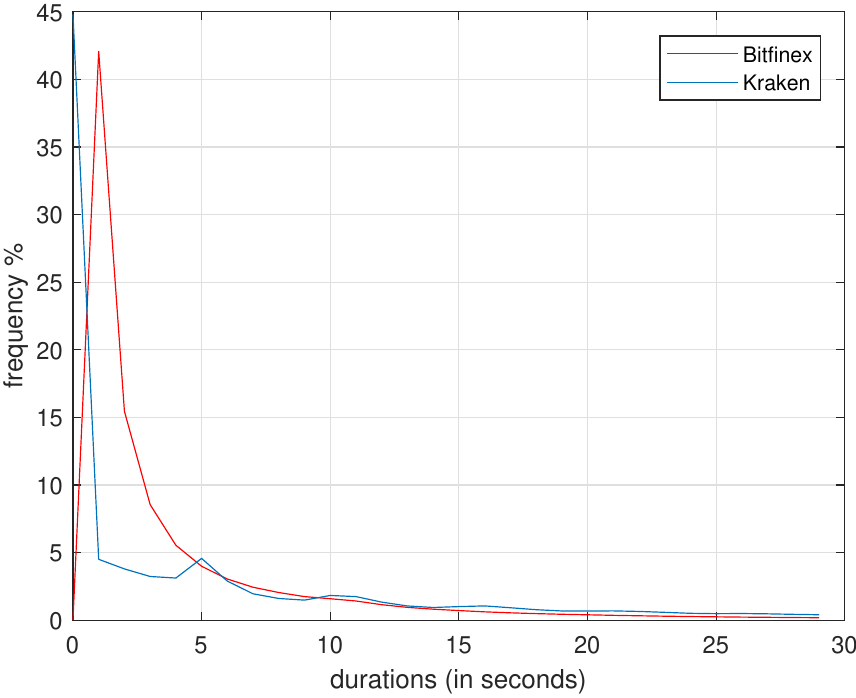
Figure 3. Distribution of price durations. Note. The figure presents the distribution of price durations of Bitfinex (red line) and Kraken (blue line). The duration length is capped at 30 s. Figure 4 sheds light on the intraday development of price durations. We split the day in 30 min intervals and calculate the average across the whole sample for the respective interval. As can be seen, there is a pronounced time-of-day effect on both exchanges: Price durations are substantially lower in the period from 8:00 a.m. UTC (Bitfinex) or 10:00 a.m. UTC (Kraken) till 12:00 a.m. UTC. These times correspond roughly to the trading times of European and U.S. stock markets. As we have Bitcoin prices denoted in U.S. dollar, this pattern is sensible. It is also in line with the findings of Baur et al. (2019) who document increased traded volume on exchanges trading in U.S. dollar during these